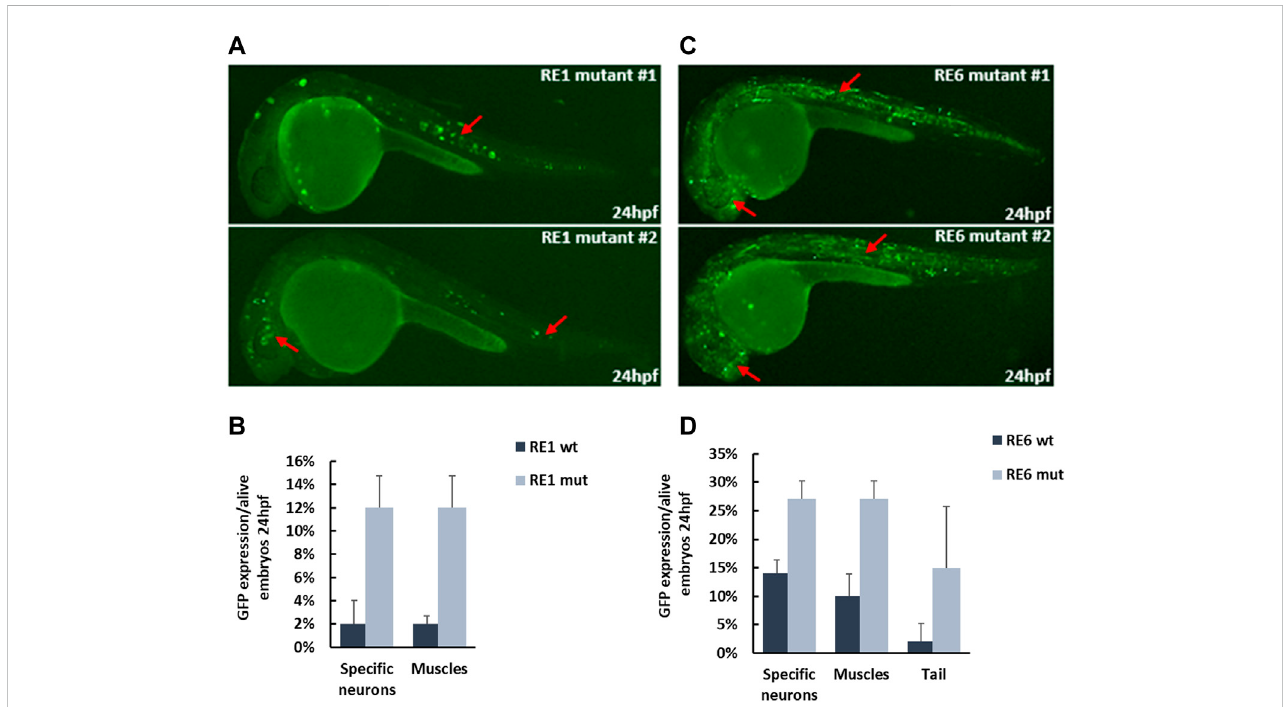
FIGURE 6 In vivo activity of repressed enhancers at 24 hpf zebra fi sh embryos. (A) RE1 mutant sequence drove GFP expression in speci fi c neurons in the brain and aroundtheeyesandnotochord(redarrows). (B) Six-foldincreaseinthenumberofpositivezebra fi shembryoswiththeRE1mutantsequencecomparedtothe reference sequence. (C) RE6 mutant sequence drove GFP expression in forebrain and somitic muscles (red arrows). (D) Two-fold increase in the number of positive zebra fi sh embryos with the RE6 mutant sequence compared to the reference